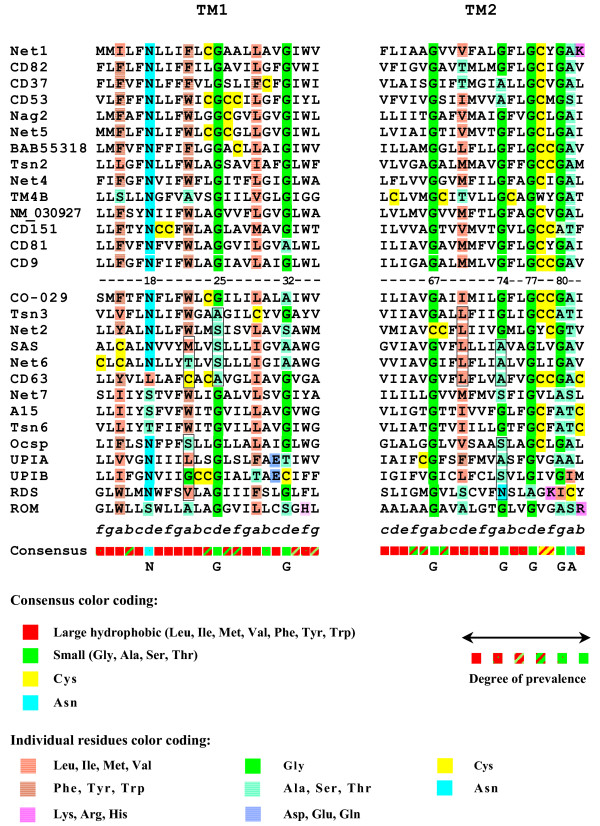
Sequence alignment of the transmembrane domains 1 and 2 of 28 human tetraspanins. Residues from select positions of the heptad motifs in TM1 and 2 are highlighted (see text for details). Also highlighted are polar residues and cysteines. Consensus residue types are shown by the color scheme indicated. Boxed residues reflect correlated substitutions for position pairs 22–74 and 25–70 (details are in the text). The numbers refer to CD9 sequence.